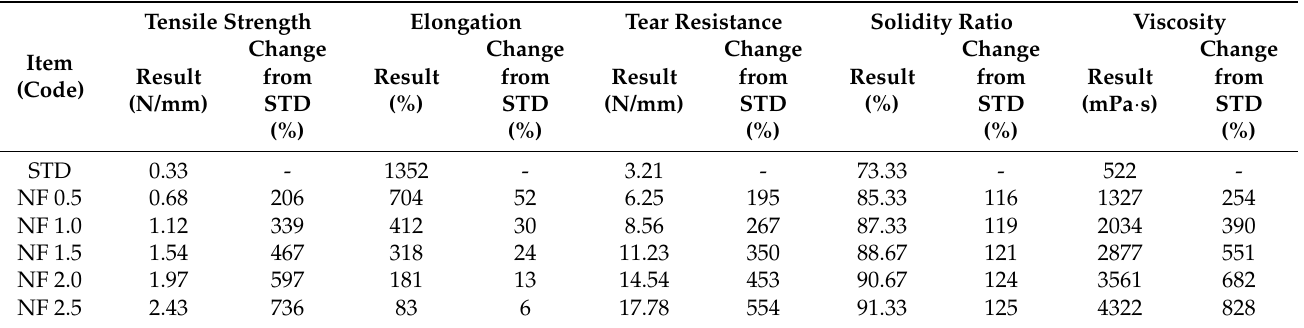
Table 8. Physical property results according to the amount of nylon fiber input and increase/decrease rate compared to STD.